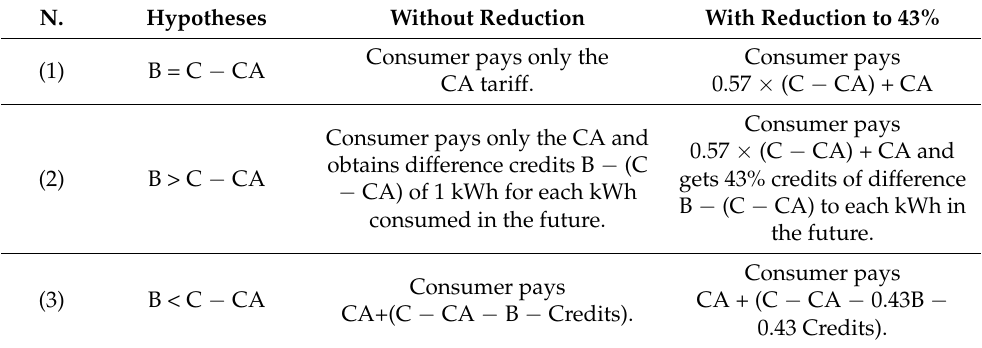
Table 3. Deterministic results after the change proposed by ANEEL.